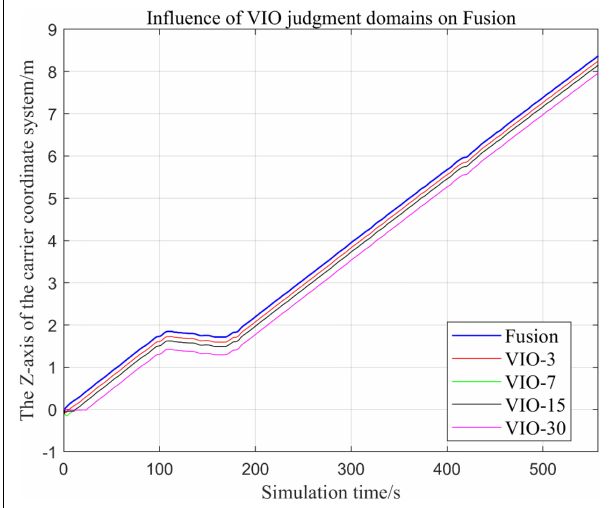
FIGURE 24 | Comparison of output x -axis local trajectories under different thresholds.